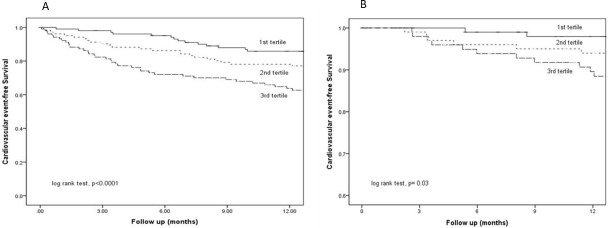
Kaplan-Meier plot of cardiovascular event-free survival with hospital admission for congestive heart failure (A) included; and (B) excluded. Patients were divided into tertiles according to their baseline E:I ratio (1st tertile: ≤0.91; 2nd tertile >0.91–1.07; 3rd tertile >1.07). Data were compared by the log rank test.